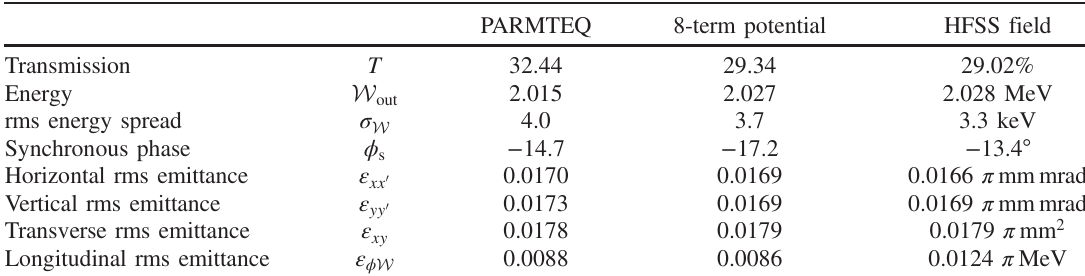
TABLE III. Output phase space parameters.